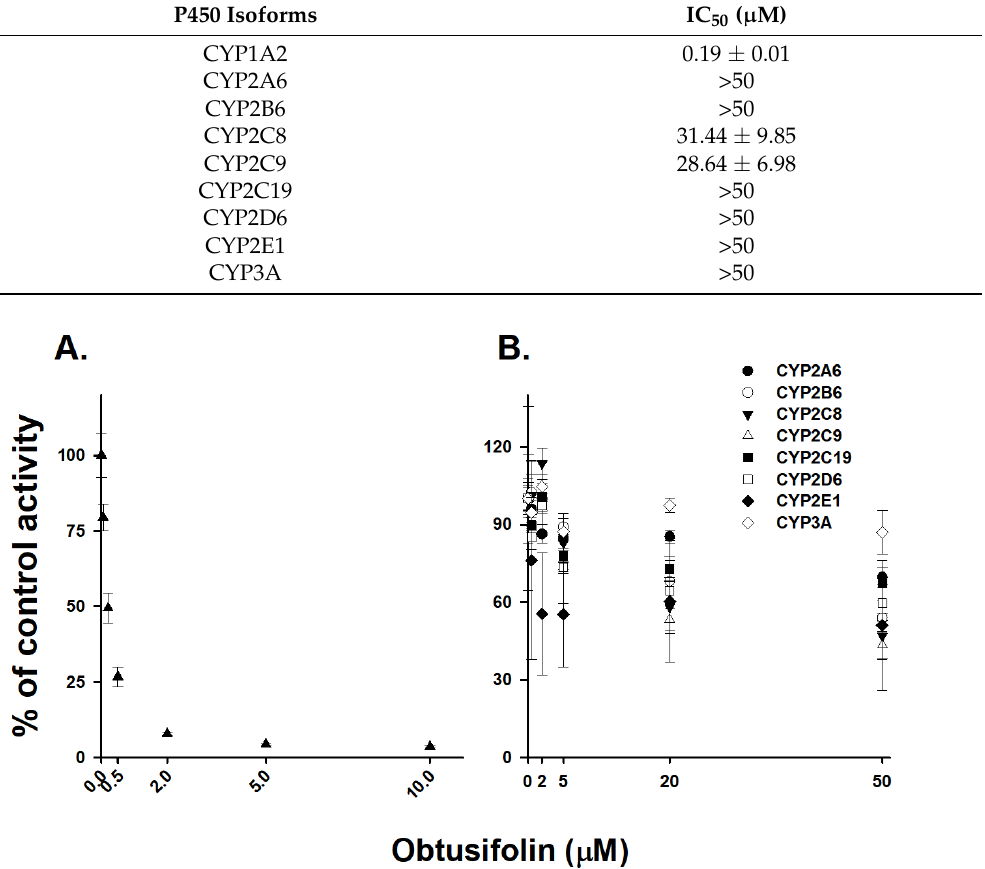
Figure 5. Inhibitory effects of obtusifolin on ( A ) phenacetin O -deethylation (CYP1A2, ▲ ) and ( B ) coumarin 7-hydroxylation (CYP2A6, ● ), bupropion 6-hydroxylation (CYP2B6, ○ ), amodiaquine N-deethylation (CYP2C8, ▼ ), tolbutamide 4-hydroxylation (CYP2C9, △ ), omeprazole 4-hydroxylation (CYP2C19, ■ ), dextromethorphan O -demethylation (CYP2D6, □ ), chlorzoxazone 6-hydroxylation (CYP2E1, ◆ ), and midazolam 1 ′ -hydroxylation (CYP3A, ◇ ) during incubation with human liver microsomes (0.25 mg/mL). The activity was expressed as the percentage of the control activity. The data are represented as the mean ± S.D. ( n = 3).